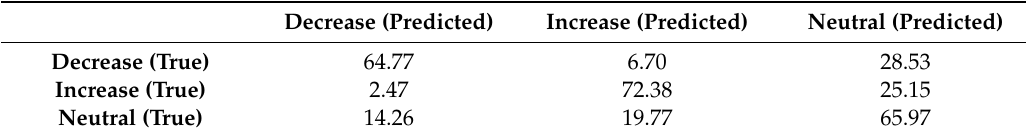
Table 2. Normalized trend forecasting test data confusion